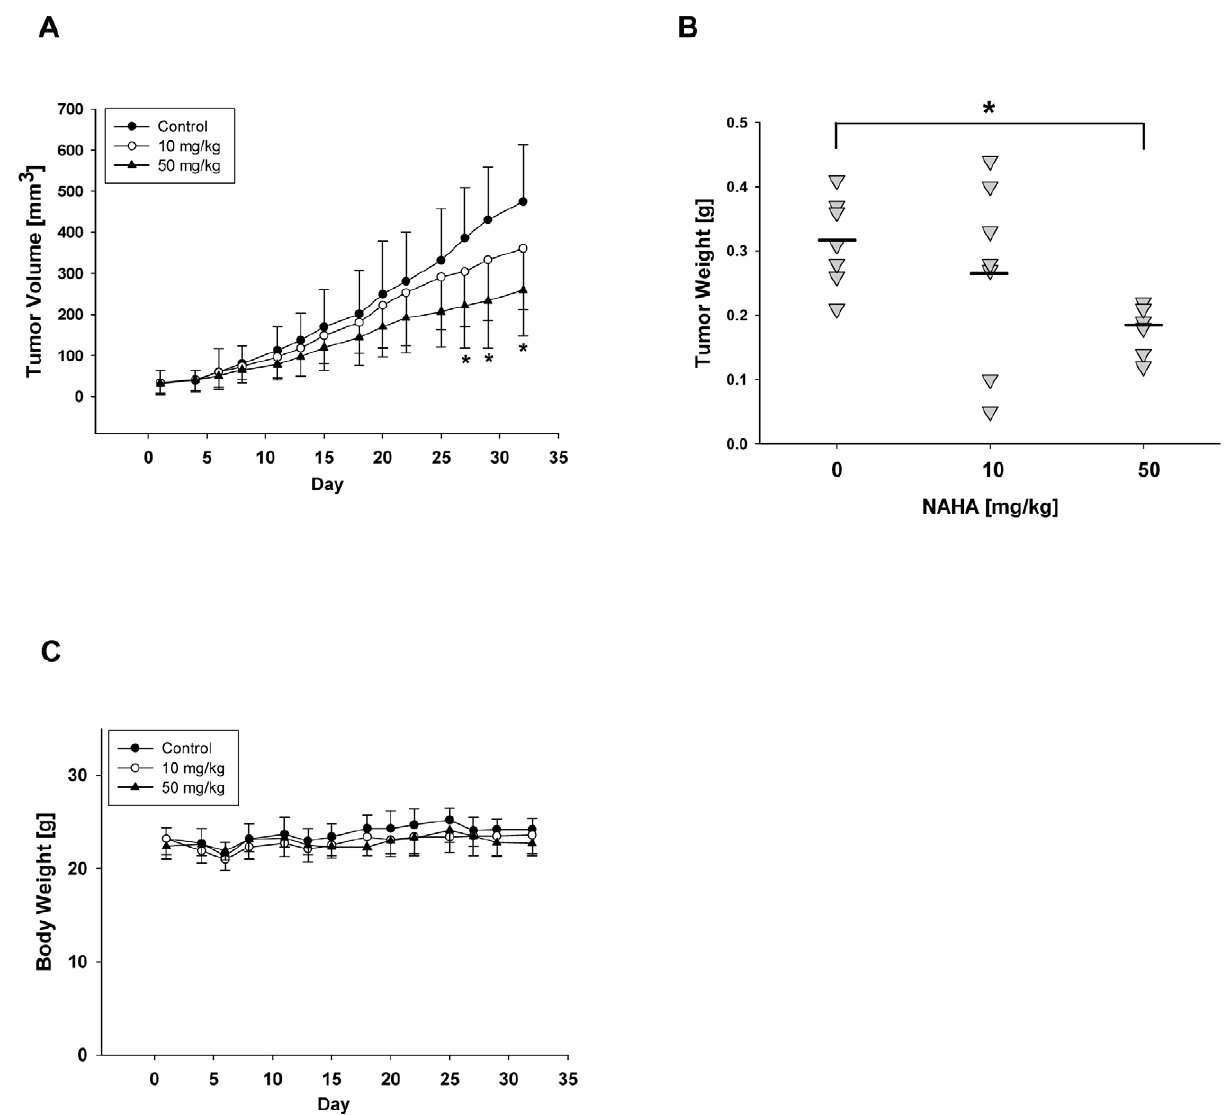
Figure 3. NAHA inhibits growth of breast cancer cells invivo . (A) Tumor volume. MDA-MB-231 cells were inoculated s.c. in the right flank of each mouse. Seven days after inoculation, mice were randomly divided into 3 groups (n=10) and treated with NAHA (i.p., 10 mg or 50 mg/kg of body weight/3 times per week) or vehicle (n=11) for 32 days. Tumor volume was measured three times a week. Data are mean 6 SD, * significantly different from control (p , 0.05) using a two-sample Student t-test. (B) Tumor weight, * p , 0.05. (C) Body weight of